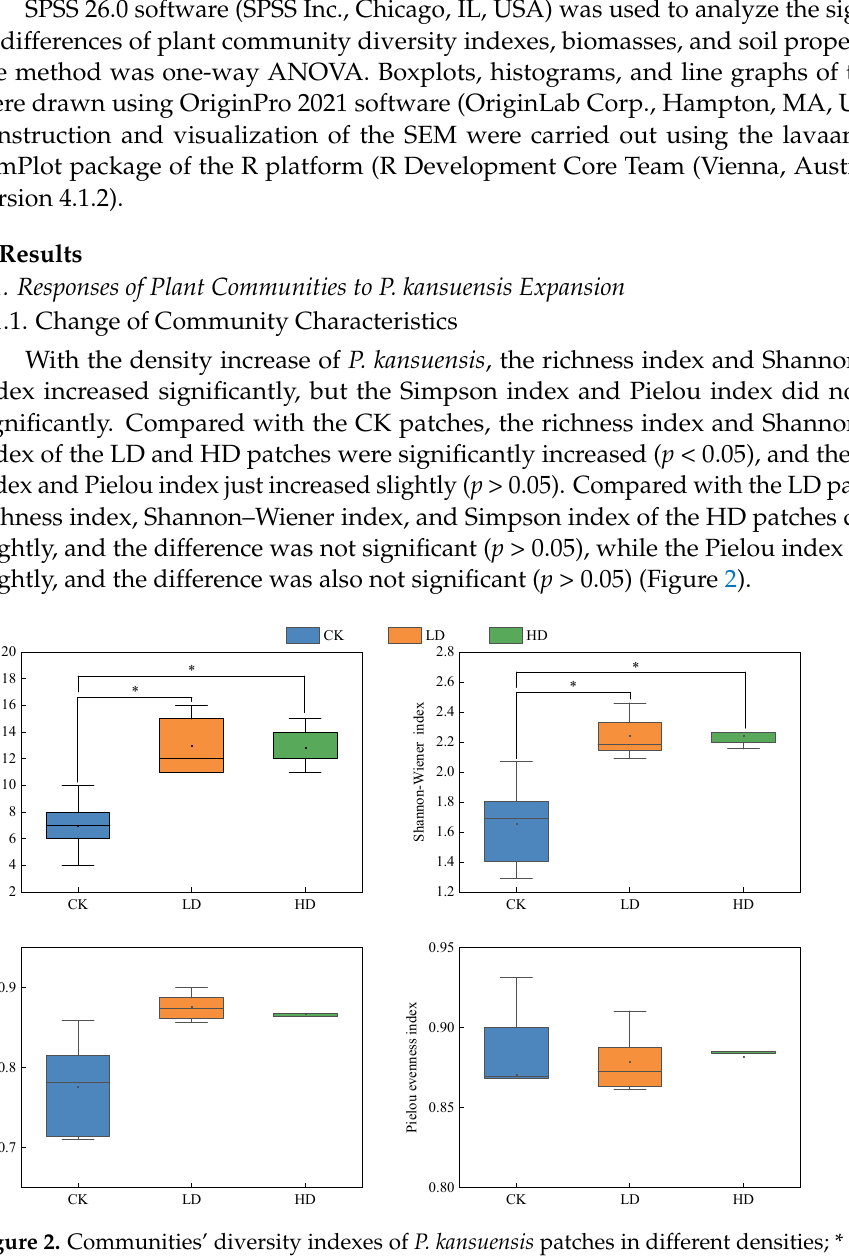
Figure 2. Communities' diversity indexes of P. kansuensis patches in different densities; * indicates a significant difference at the 0.05 level.